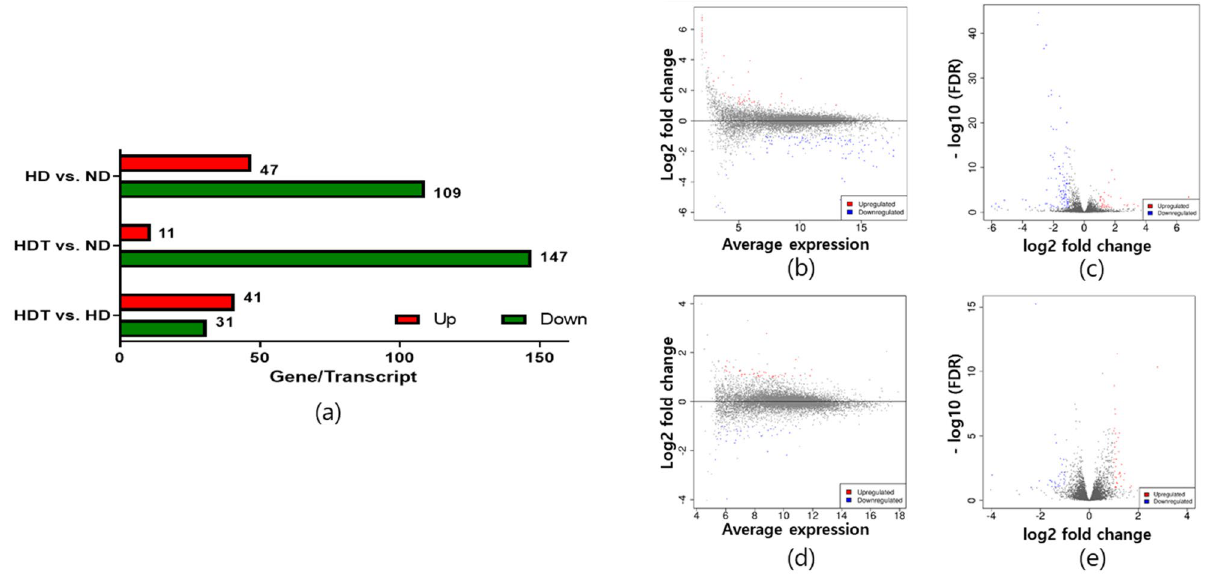
Figure 3. Plots to visualize the DEGs between the groups. ( a ) The number of Differentially expressed genes between all groups. ( b ) The MA plots of DEGs between the ND and the HD groups. ( c ) The Volcano plots of DEGs between ND and HD groups. ( d ) The MA plots of DEGs between the HD and the HDT groups. ( e ) The Volcano plots of DEGs between HD and HDT groups. ND normal diet group, HD high energy intake group, HDT high energy intake with BG&SW supplements treatment group.